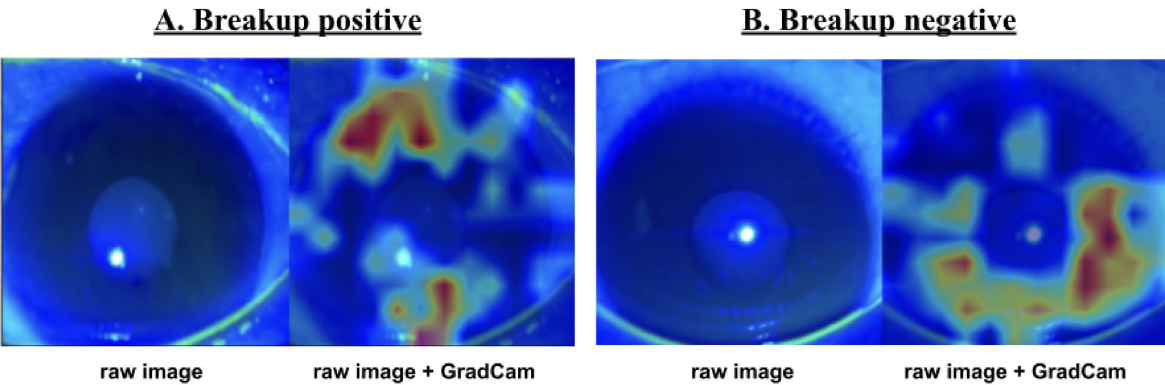
Figure 4. Visualization using GradCAM. ( A ) Visualization using Gradient-weighted class activation mapping (GradCAM) in a “breakup positive” frame. The raw image and GradCAM image with heatmap guidance. The black spots that display the breakup area are emphasized by the heatmap in the "raw image + GradCAM". ( B ) Visualization using GradCAM in a “breakup negative” frame. The raw image and GradCAM image with heatmap guidance. No emphasis on the cornea.